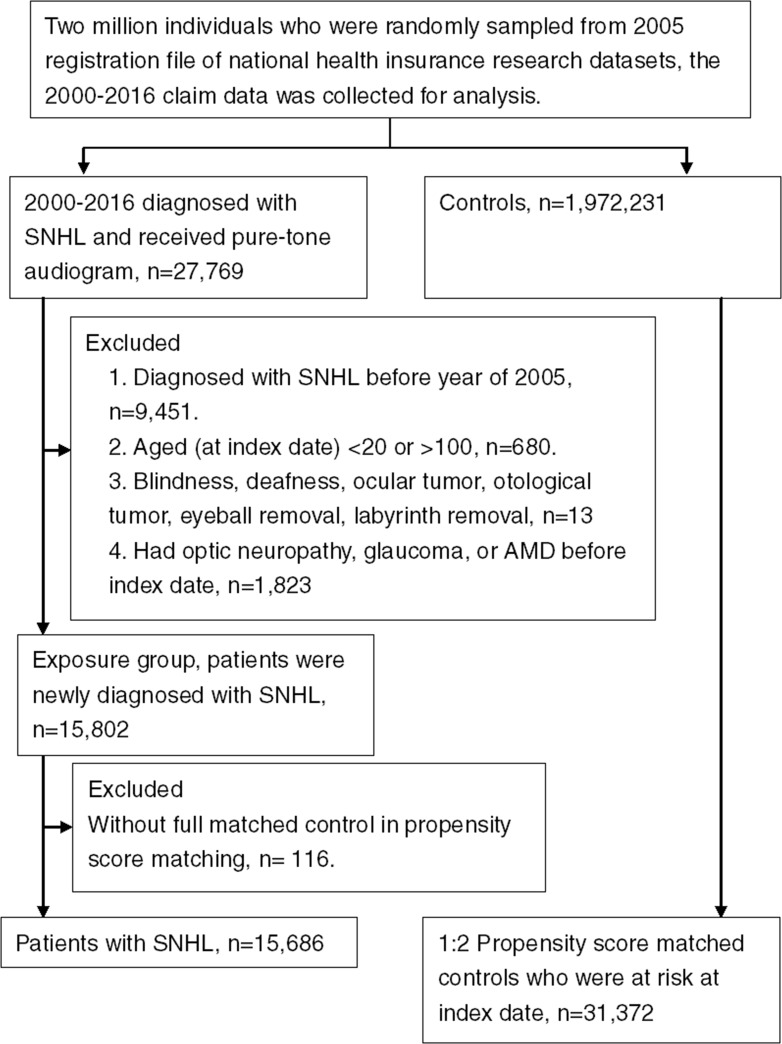
The flowchart of subject selection.SNHL: sensorineural hearing loss.